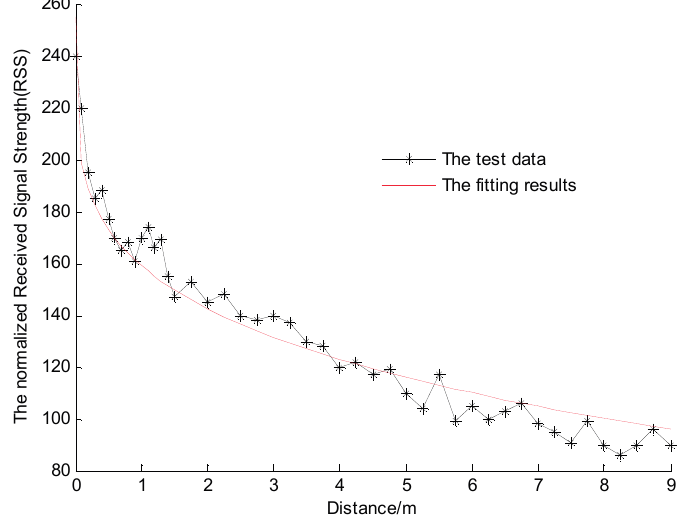
Figure 6. The fitting results of the relationship in outdoor test site.